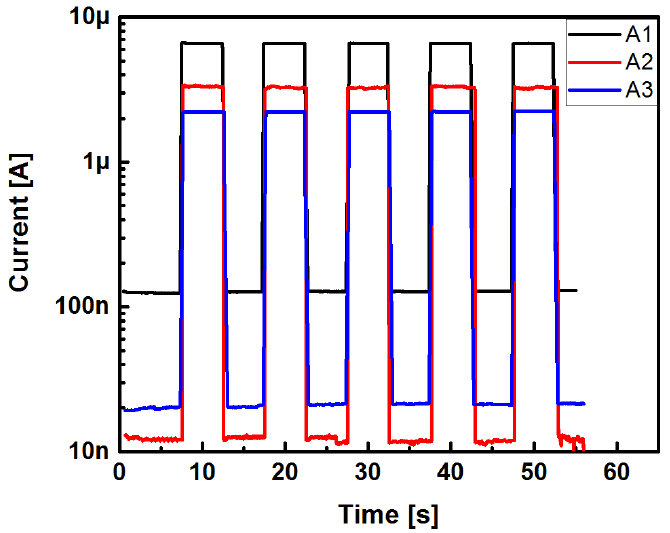
Figure 14. Switching response of Au/SRO/Si structures under white light illumination .